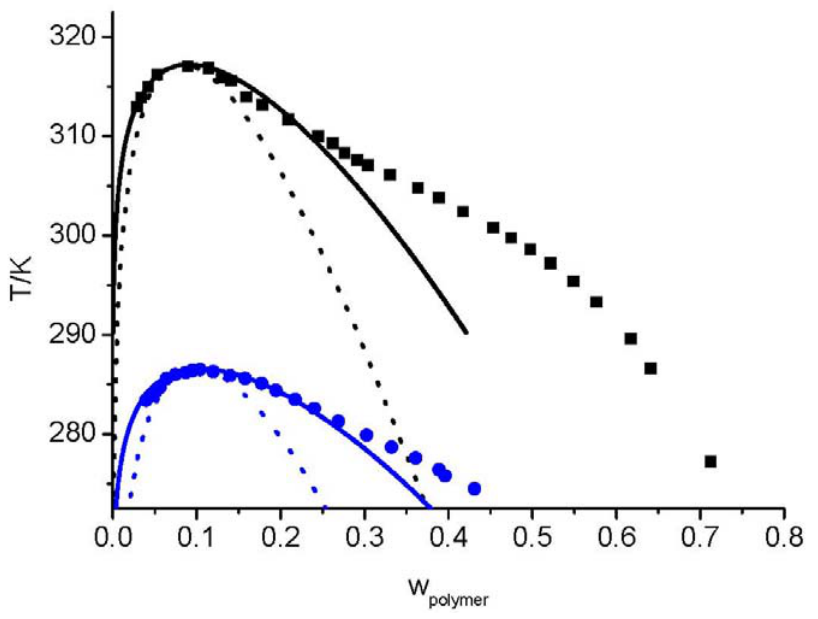
Figure 9. Phase behaviour of Boltorn U3000 in different solvents (propan-1-ol: black squares [128], butan-1-ol: blue circles [58]). The dotted lines are calculations based on LCT and the solid lines are calculations based on LCT + Wertheim approach, where the used parameters are listed in Tables 5 and 6